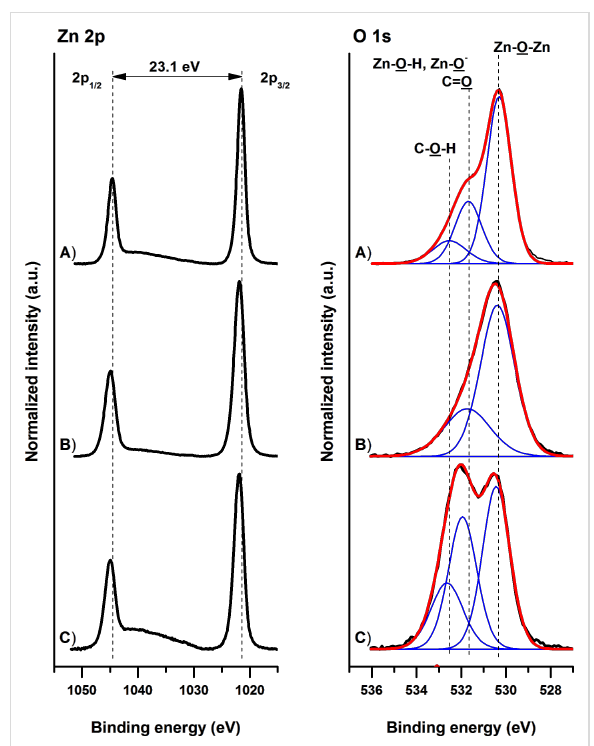
Figure 2: High-resolution core-level Zn 2p and O 1s XPS spectra of pristine (A) ZnO NCs and ZnO NCs after 25 min treatment in (B) H- and (C) O-plasmas. Measured spectra are presented with black lines, while their corresponding fitted envelopes are presented in red. The individual contributions of different functional groups present in the ZnO nanocolumns are represented with blue lines.